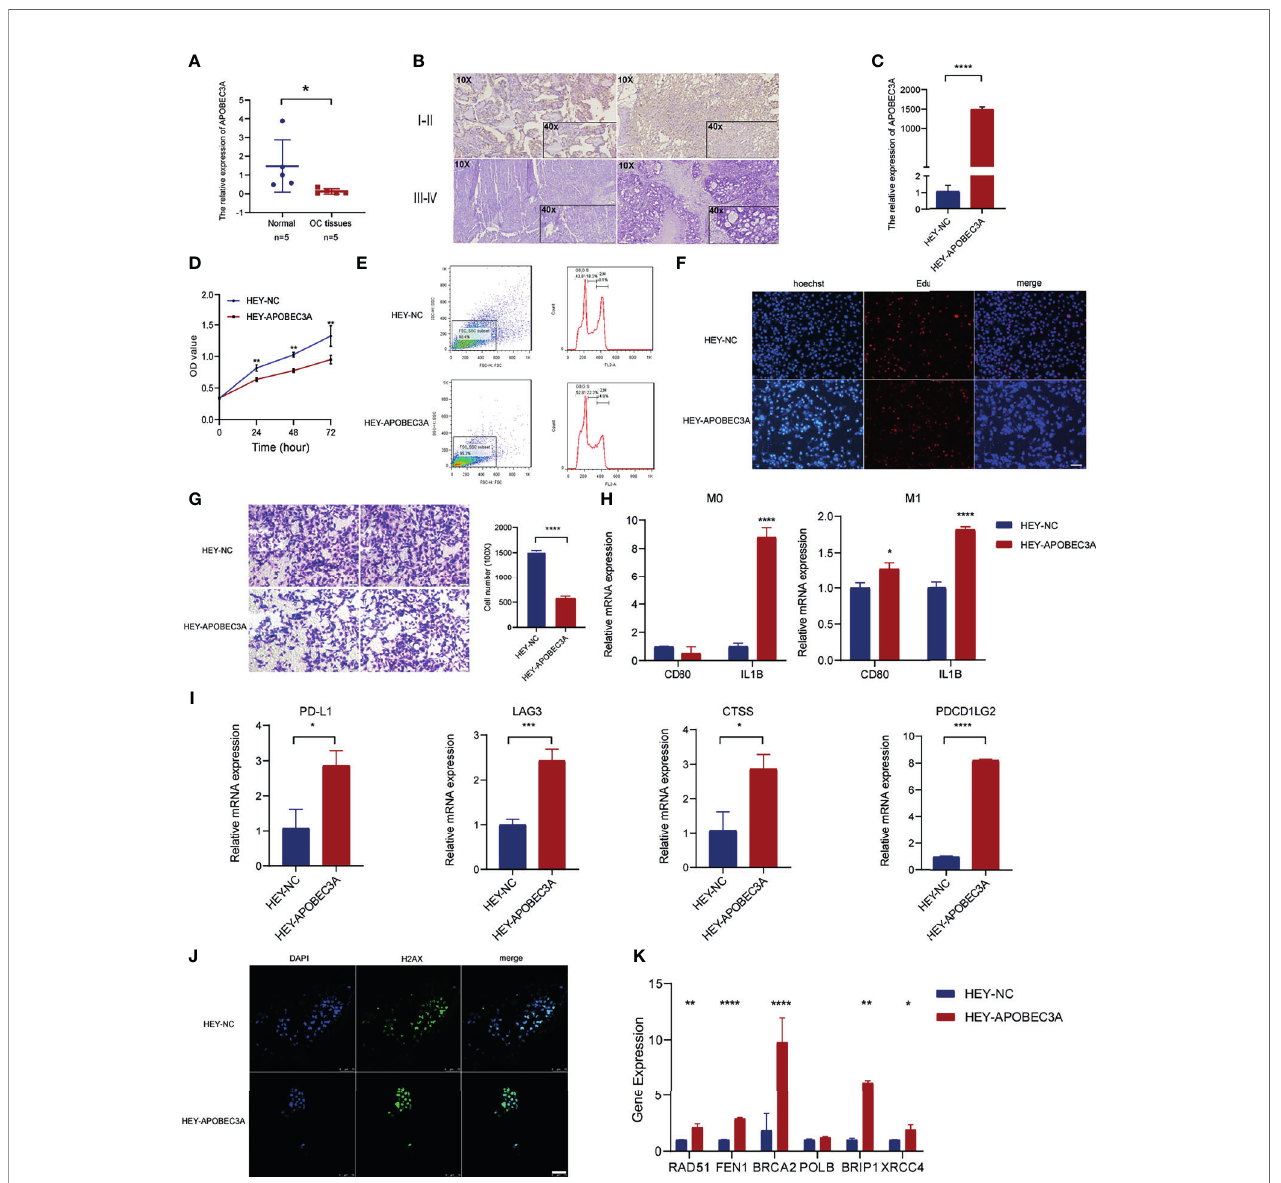
FIGURE 8 | Functional veri fi cation of APOBEC3A in ovarian cancer (OC) cells. (A) The mRNA level of APOBEC3A in fi ve OC tissues and fi ve normal ovarian tissues. (B) The expression of APOBEC3A protein in I – II stage and III – IV stage OC tissues was detected by IHC (magni fi cation ×100 and ×400). (C) The transfection ef fi ciency of APOBEC3A was veri fi ed in HEY cells by RT-qPCR. (D) APOBEC3A-reduced proliferation rate of HEY cells by CCK-8. (E) Flow cytometry analysis showed overexpression of APOBEC3A enhanced HEY cell cycle arrest. APOBEC3A increased the percentage in the G0/G2 phase compared with HEY-NC cells. (F) EdU assay showed that the proliferative ability of HEY cells was inhibited by APOBEC3A. Nuclei are shown in blue (Hoechst) (magni fi cation ×100) (G) Transwell assay showed cell migration ability of HEY cells was inhibited by APOBEC3A compared with HEY-NC cells. Bar equals 100 µm. (H) Co-culture assay showed APOBEC3A overexpressed in HEY promoted the expression of M1 markers (CD80 and IL1B) in macrophages (M0 and M1). (I) RT-qPCR showed that APOBEC3A was positively correlated with PD-L1, LAG3, CTSS, and PDCD1LG2. (J) H2Ax immuno fl uorescence showed that DNA damage foci formation was increased in HEY- APOBEC3A cells. Nuclei are shown in blue (DAPI). Green: H2Ax foci. Bar equals 75 µm. (K) RT-qPCR showed that APOBEC3A was positively correlated with RAD51, FEN1, BRCA2, BRIP1, and XRCC4. All * p < 0.05, ** p < 0.01, *** p < 0.001, **** p < 0.0001; the data represent the mean ± SD from triplicate